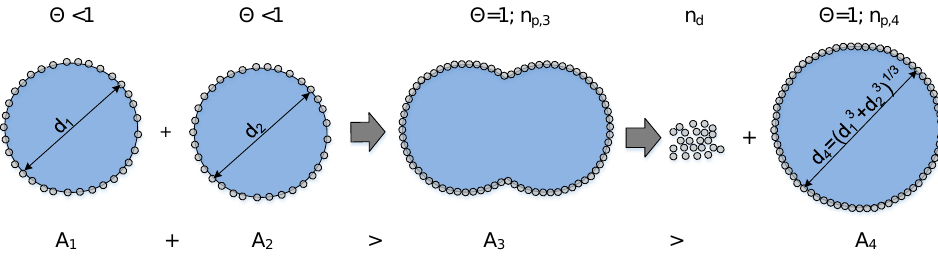
Figure 8. Number of particles n d that theoretically need to be removed from the interface during the coalescence process of two drops that are covered with particles. The energy needed to desorb particles from the interface is equal to an energy barrier against coalescence, based on